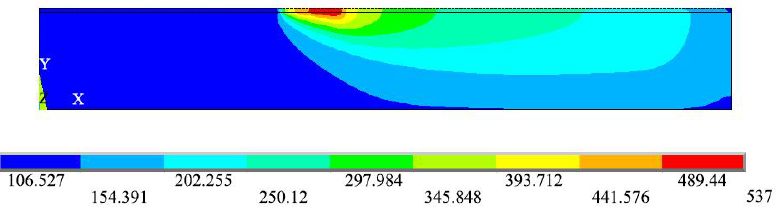
Figure 9. Temperature fields of each layer at v = 20 mm/s and T = 700 °C.